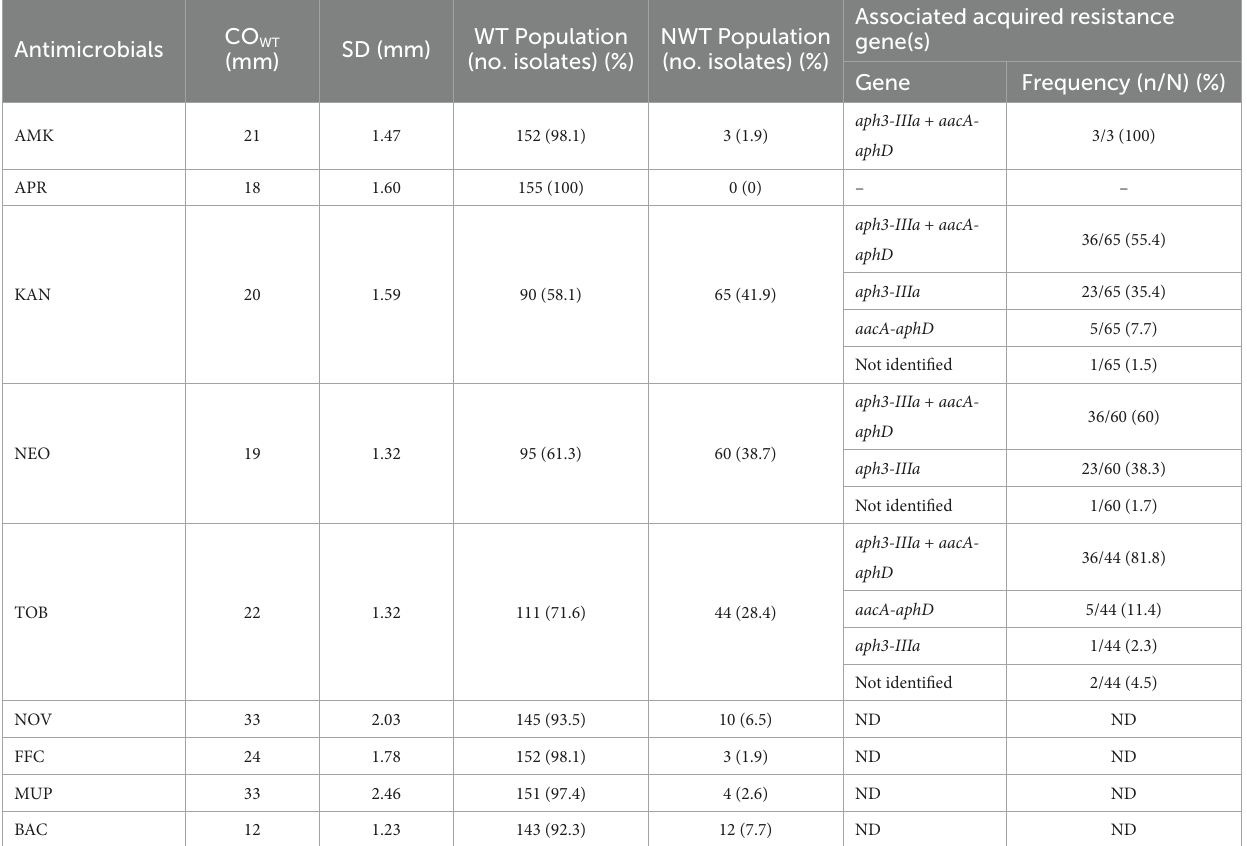
TABLE 2 Cut-off (CO WT ) values of the 155 S. pseudintermedius for antimicrobials without available breakpoints, determined based on the distribution of the zones of inhibition (mm), according to the normalized resistance interpretation method.